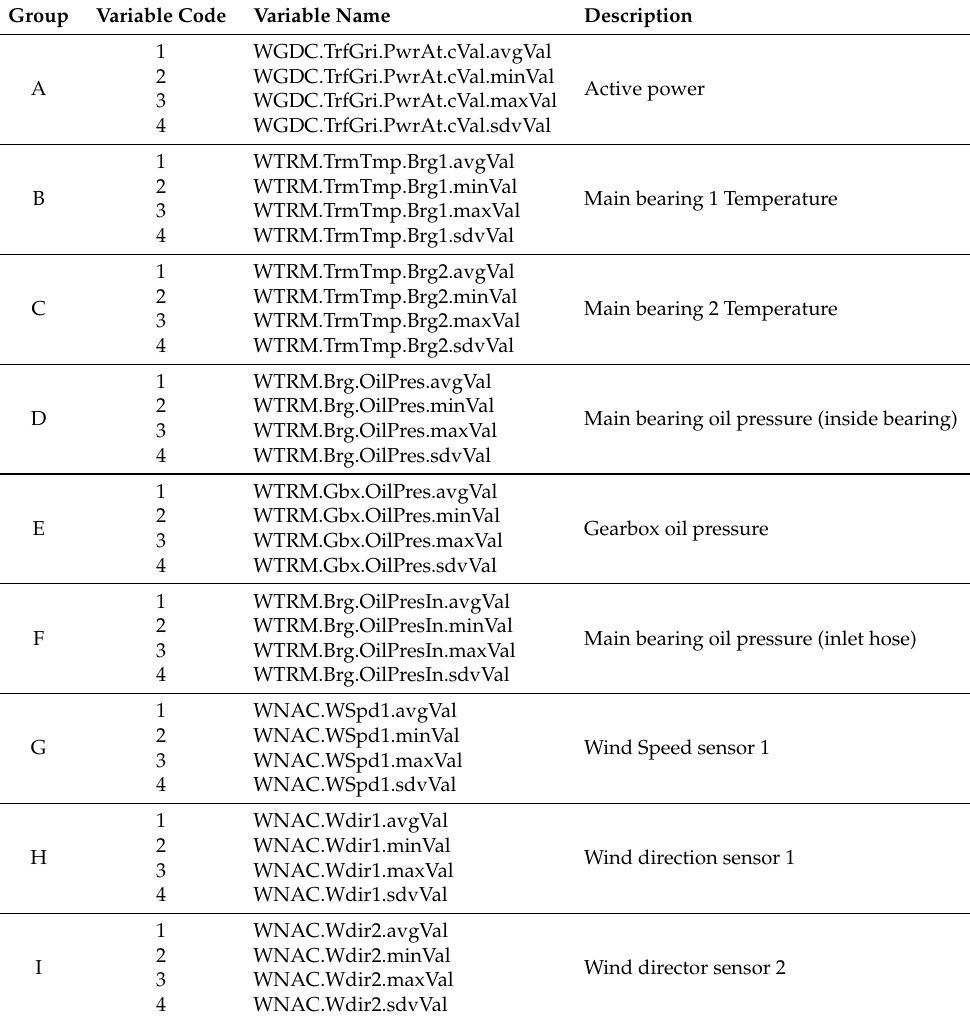
Table 2. Variable code to variable